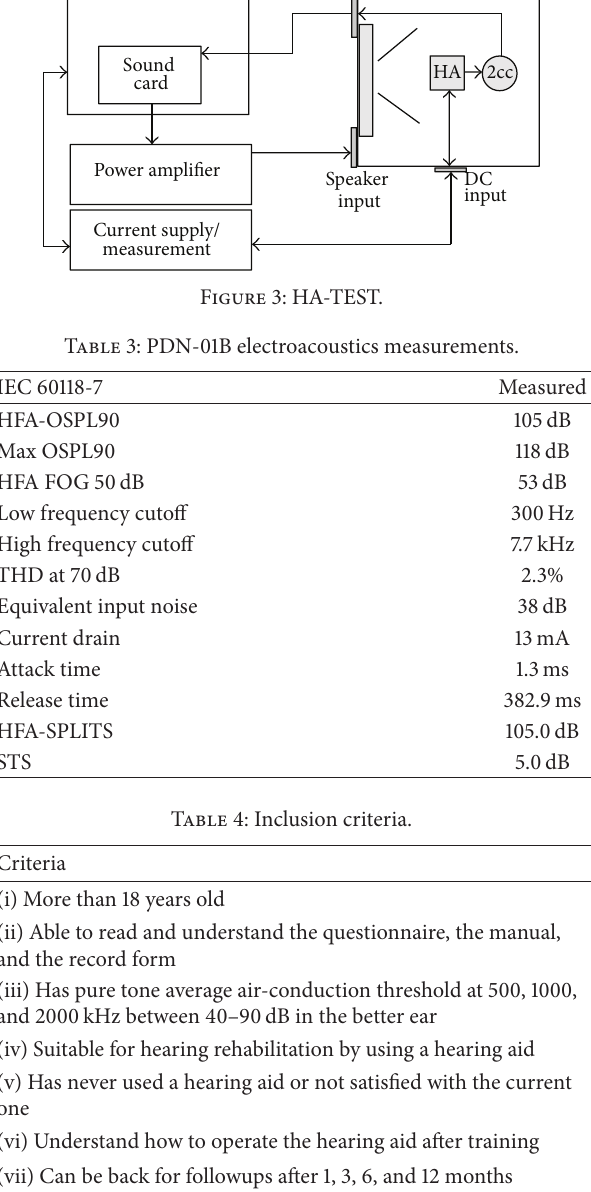
Table 5: Participants’ characteristics. Trial